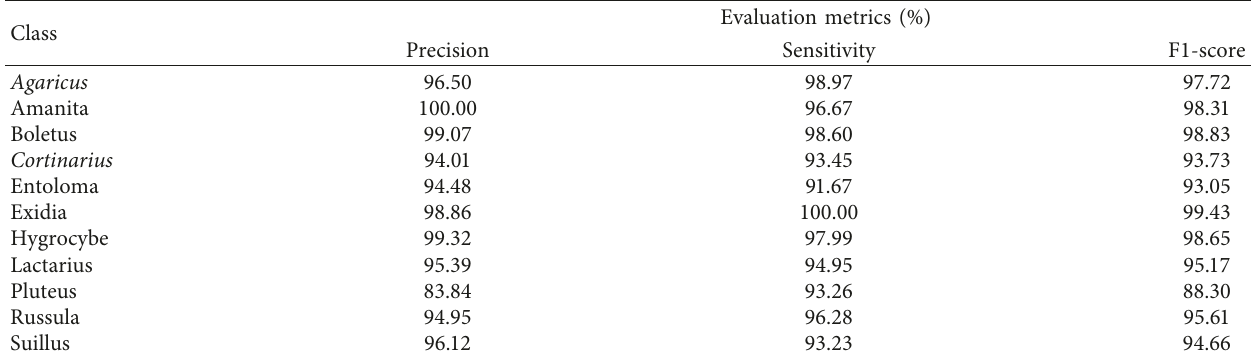
Table 3: Classification evaluation results of ViT-mushroom.